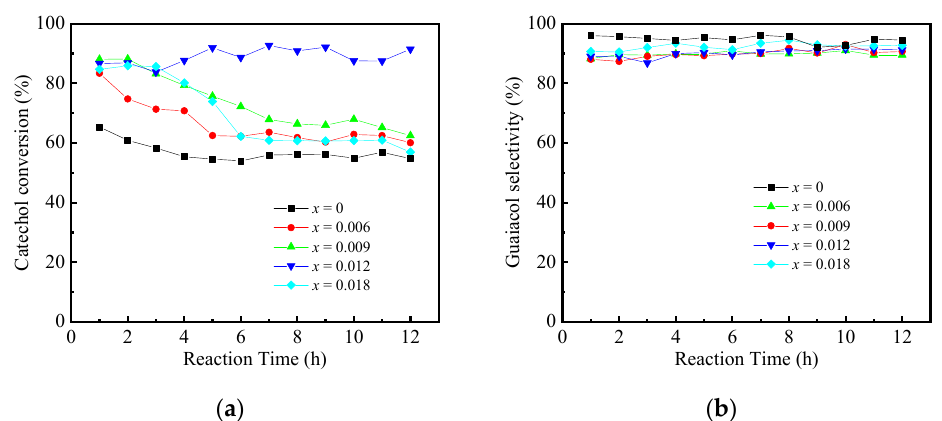
Figure 6. Catalytic performance of AlP 1.1 Zr x -400 catalysts. ( a ) catechol conversion; ( b ) guaiacol selectivity. Reaction condition: m cat = 2 g, Reaction temperature = 553 K, LHSV = 0.2 h − 1 , methanol/catechol = 5 (mol).